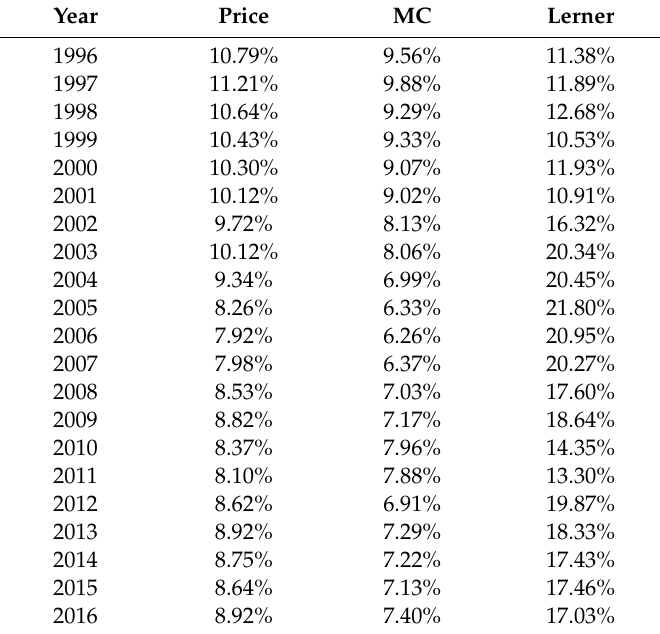
Table 4. Lerner Index: 1996–2016.